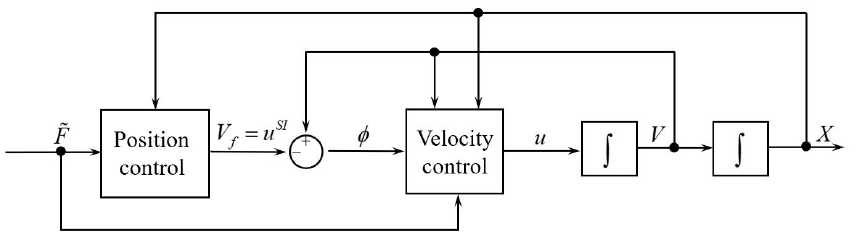
Figure 2. Second-order integrator control